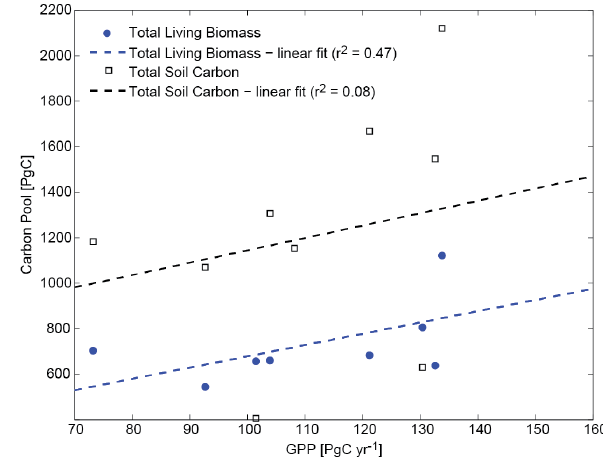
Figure 7 Fig. 7. Global aggregated steady-state GPP versus total soil carbon, and total living biomass for MsTMIP models from RG1